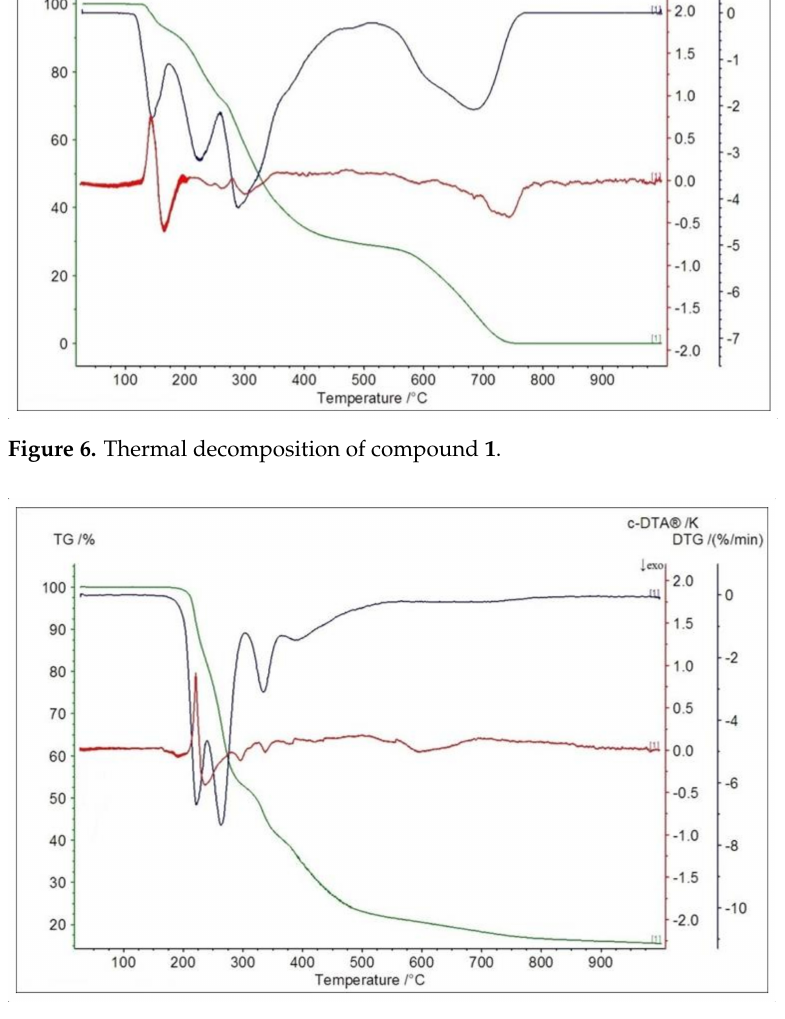
Figure 7. Thermal decomposition of compound 2 .